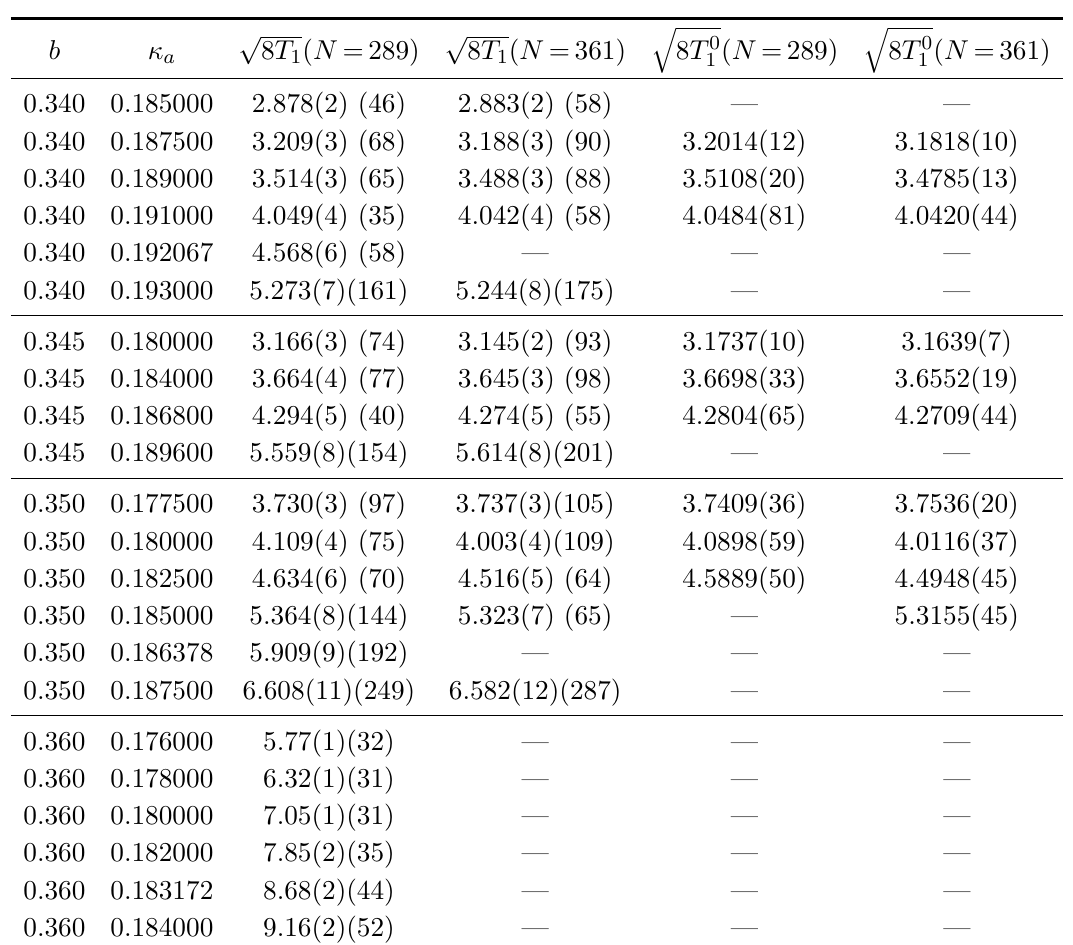
Table 9. Values of the scale √ 8 T N = 289 and N = 361 . 1 determined from the flow data with Results labelled as T 1 come from a fit to eq. (C.3) with 3 free parameters of the β -function on top of the two universal ones, as described in the text. Values labelled as T 0 are directly determined by 1 interpolation in the cases in which T 1 falls within the scaling window given by eq. (6.4) with γ = 0 . 28